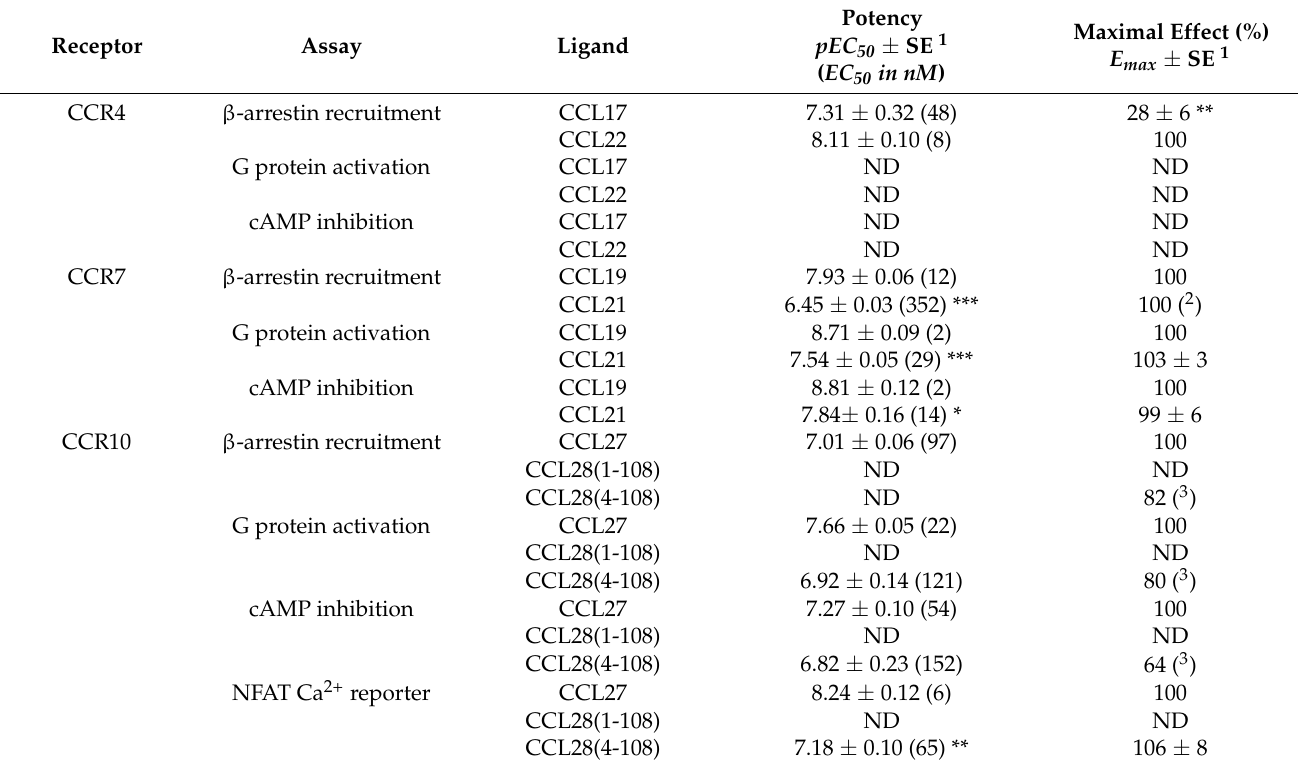
Table 1. Potencies and maximal effects of cognate chemokines at CCR4, CCR7 and CCR10 1 .